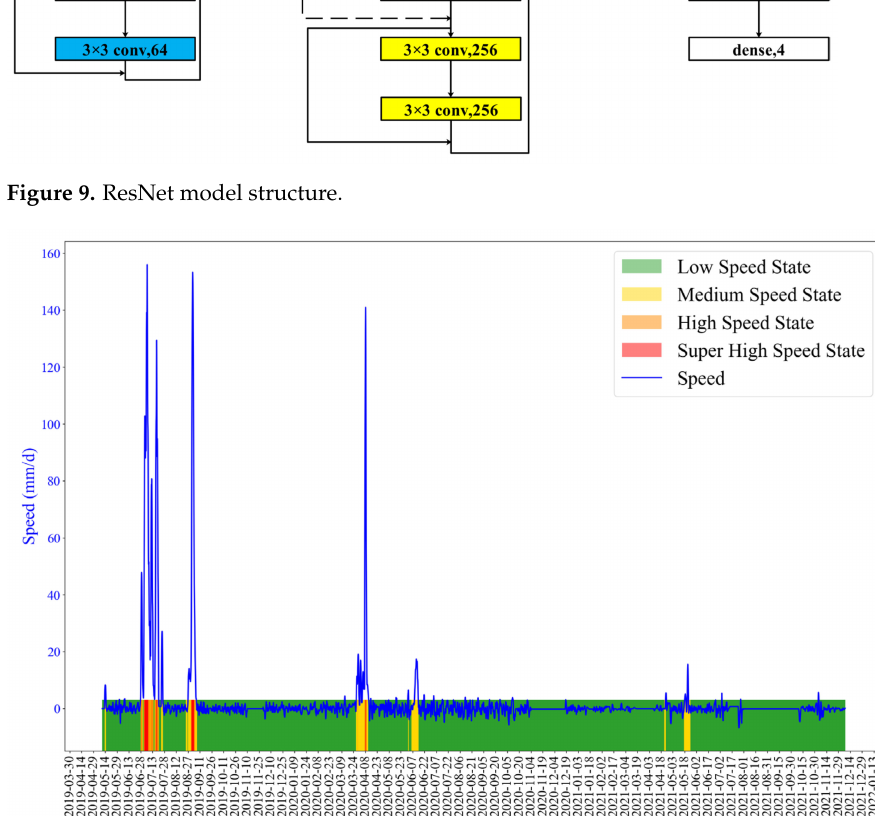
Figure 10. ResNet warning results of the Zhongma